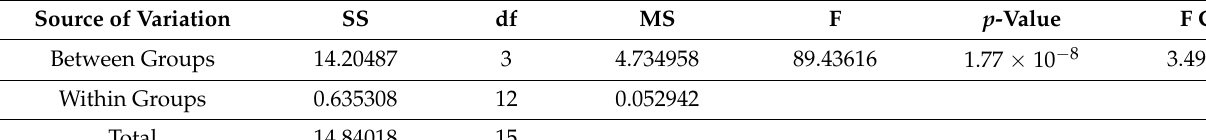
Table 5. A one-way ANOVA analysis of the abrasion resistance results.